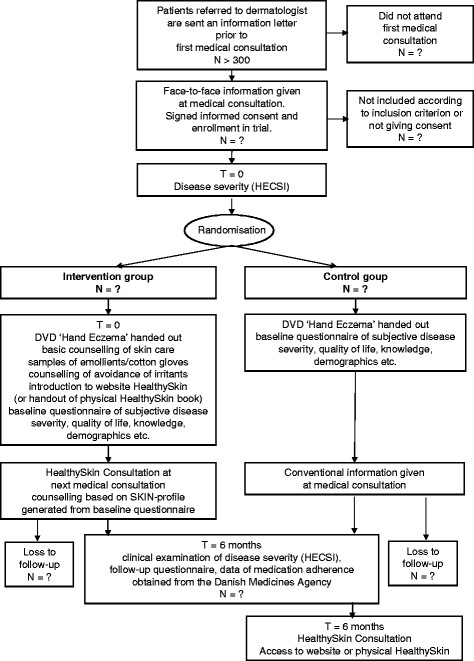
Trial flow chart.